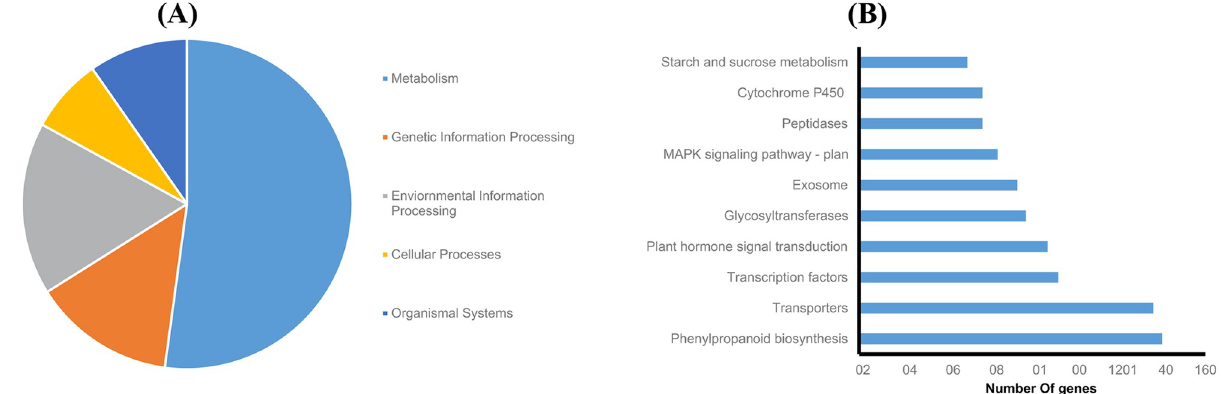
Fig 2. KEGG categorization of the DEGs. (A) Categorization of the DEGs into five chief KEGG classes. (B) The top 10 pathways with the highest gene number.